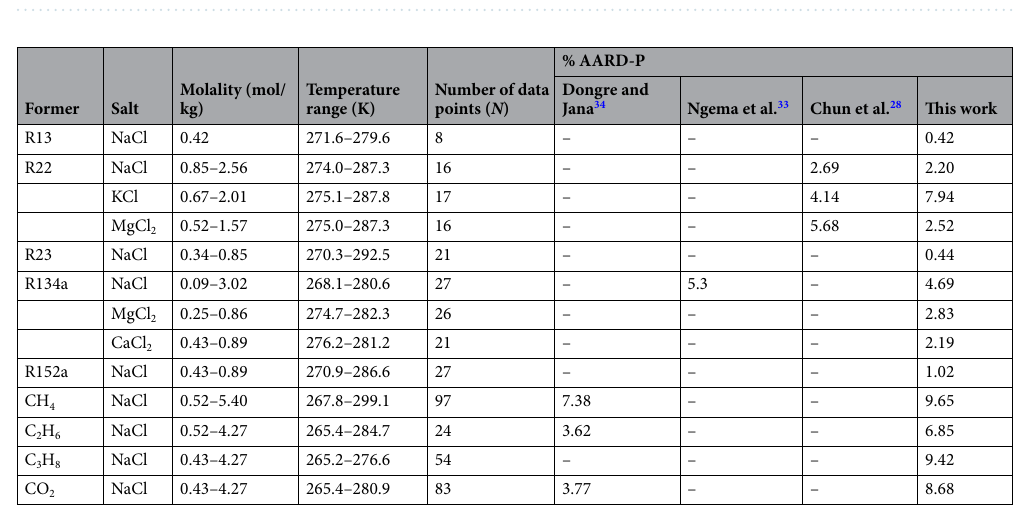
Figure 4. Comparison of phase equilibrium conditions of experimental data with model estimate for refrigerant hydrate formers at different salt concentration in water for ( a ) R22 and ( b ) R134a refrigerants. Model predictions in the presence of NaCl and MgCl 2 salts are commonly depicted by solid and dashed lines, while the dotted lines portray KCl and CaCl 2 salts for the hydrates of R22 45 and R134a 31,33,51 respectively. The individual molalities for each salt are grouped and presented correspondingly.